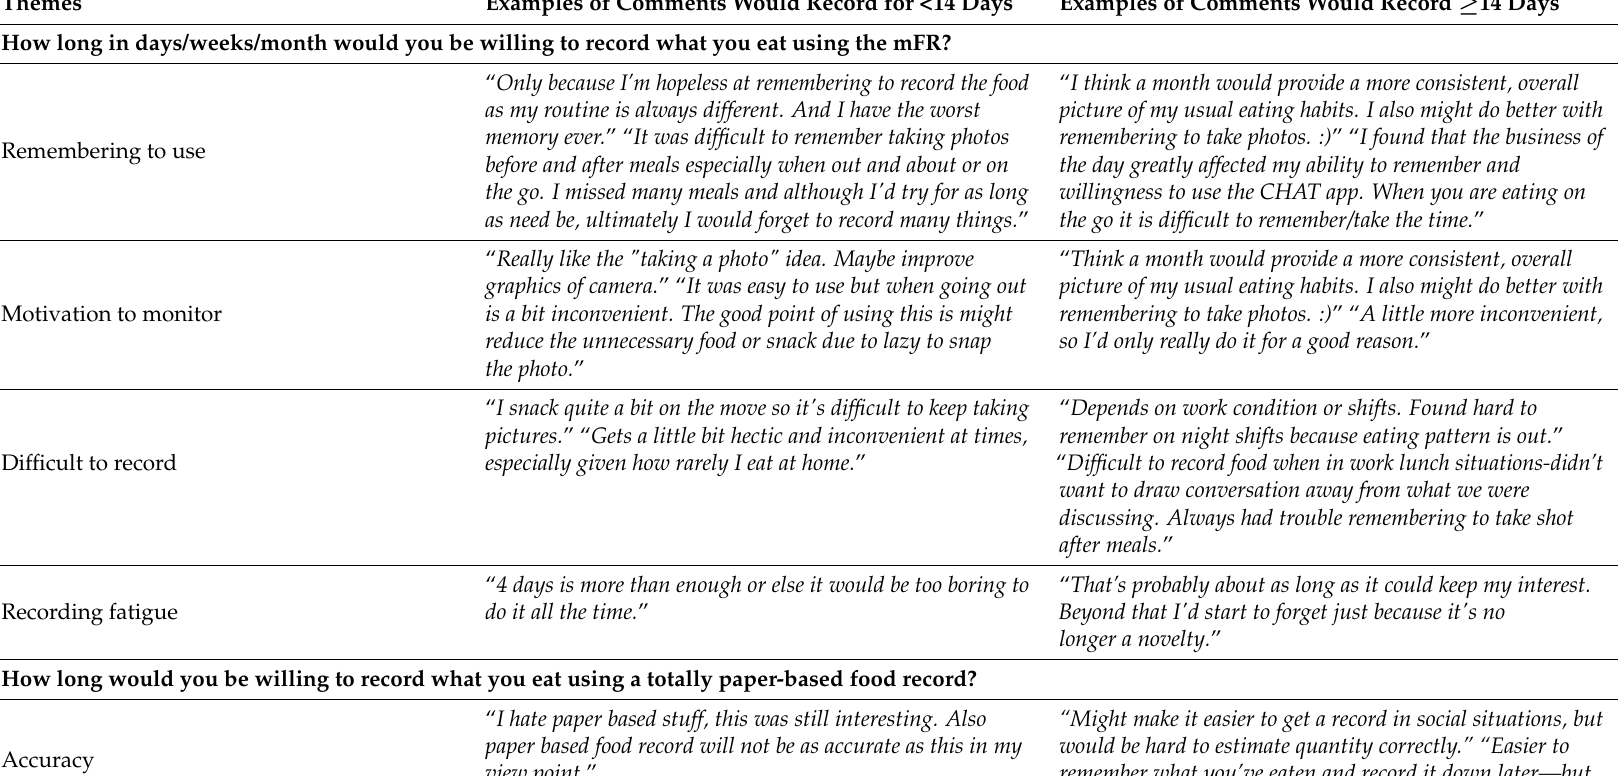
Table 4. Open-ended responses of adults regarding the use of the mobile food record comparing those who would be willing to record with the mFR for less than 14 days with those willing to record for 14 days or